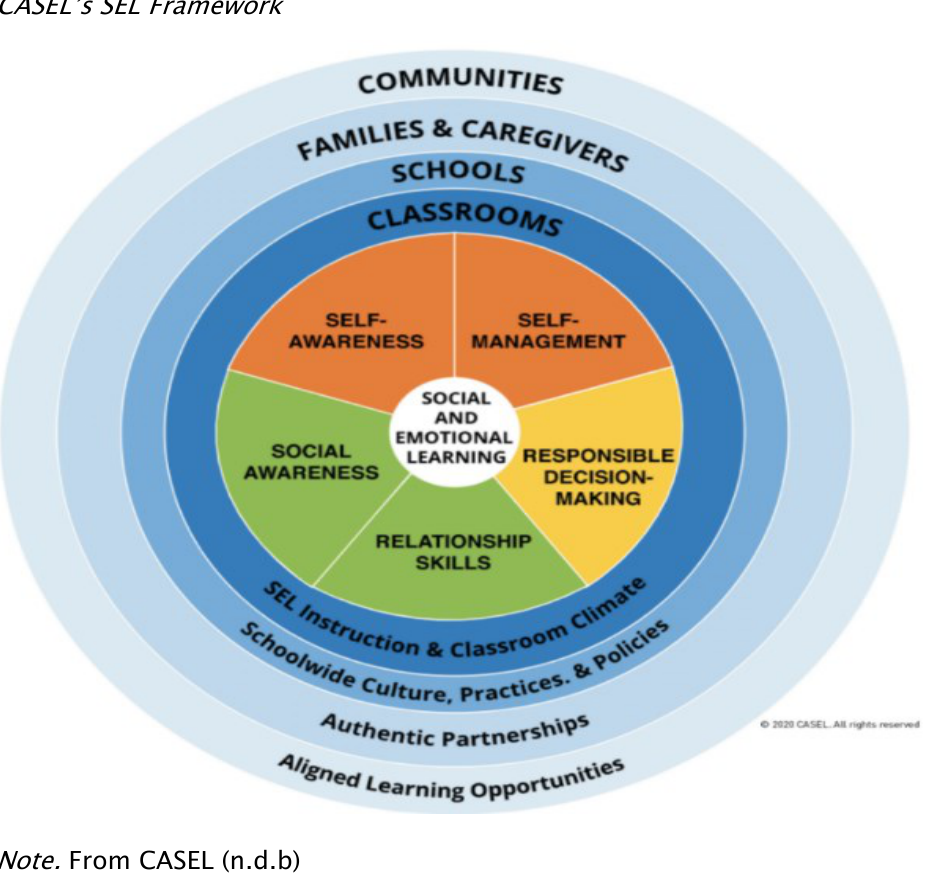
Figure 1 CASEL’s SEL